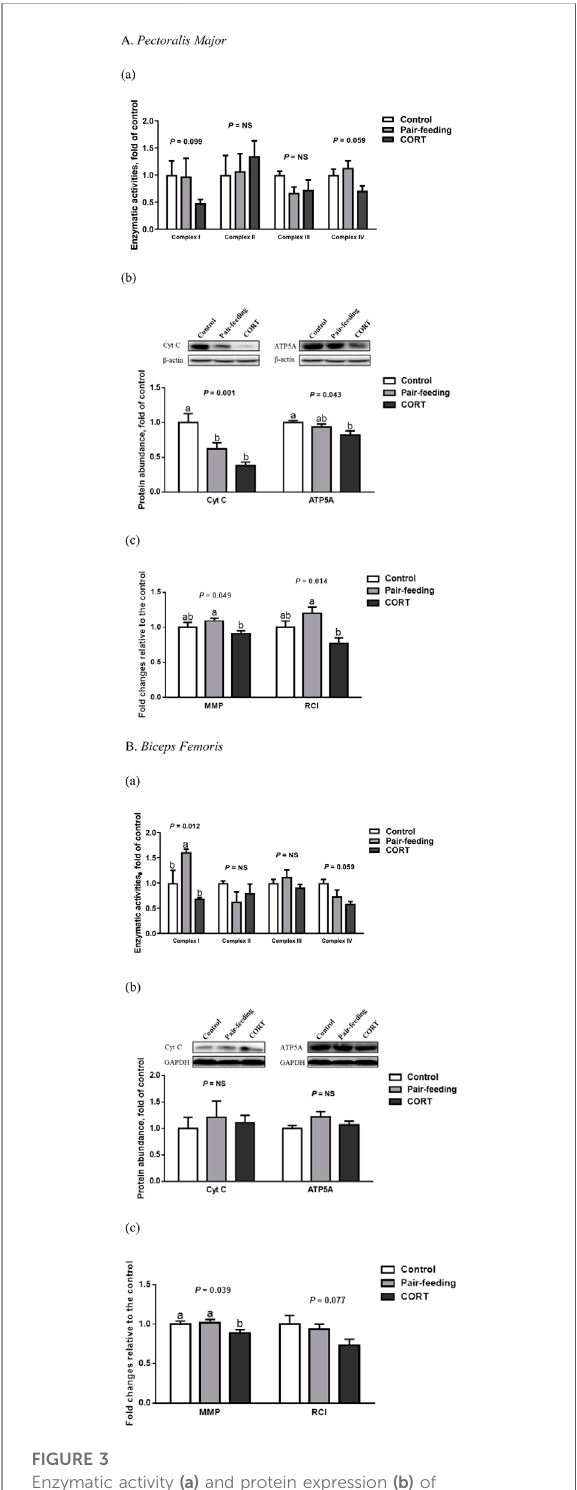
FIGURE 3 Enzymatic activity (a) and protein expression (b) of mitochondrial respiratory chain complexes, and mitochondrial coupling ef fi ciency (c) in pectoralis major (A) and biceps femoris (B) muscles of broiler chickens treated with corticosterone (CORT, 30 mg/kg diet from 30 to 37 d of age). Data are means of 12 individuals of 2 birds per replicate. a,b Means without a common